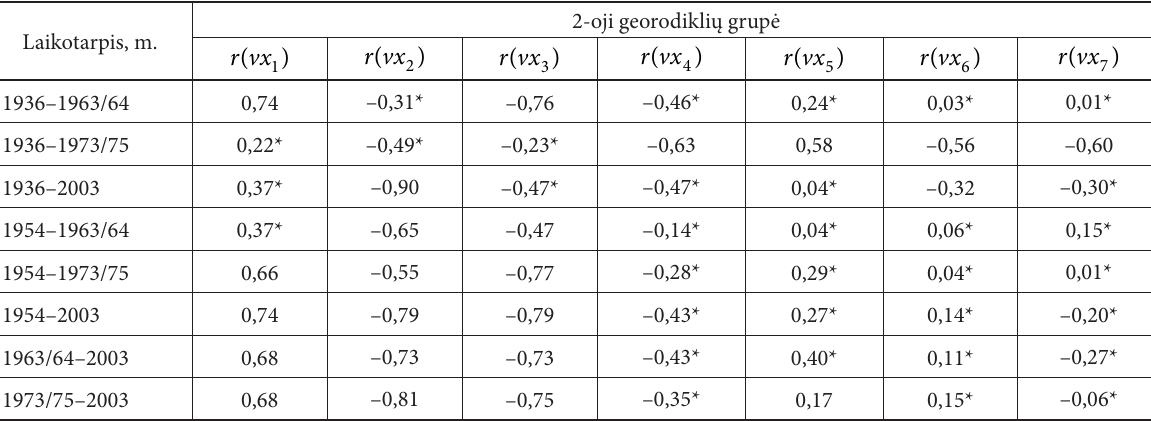
2-oji georodiklių grupė